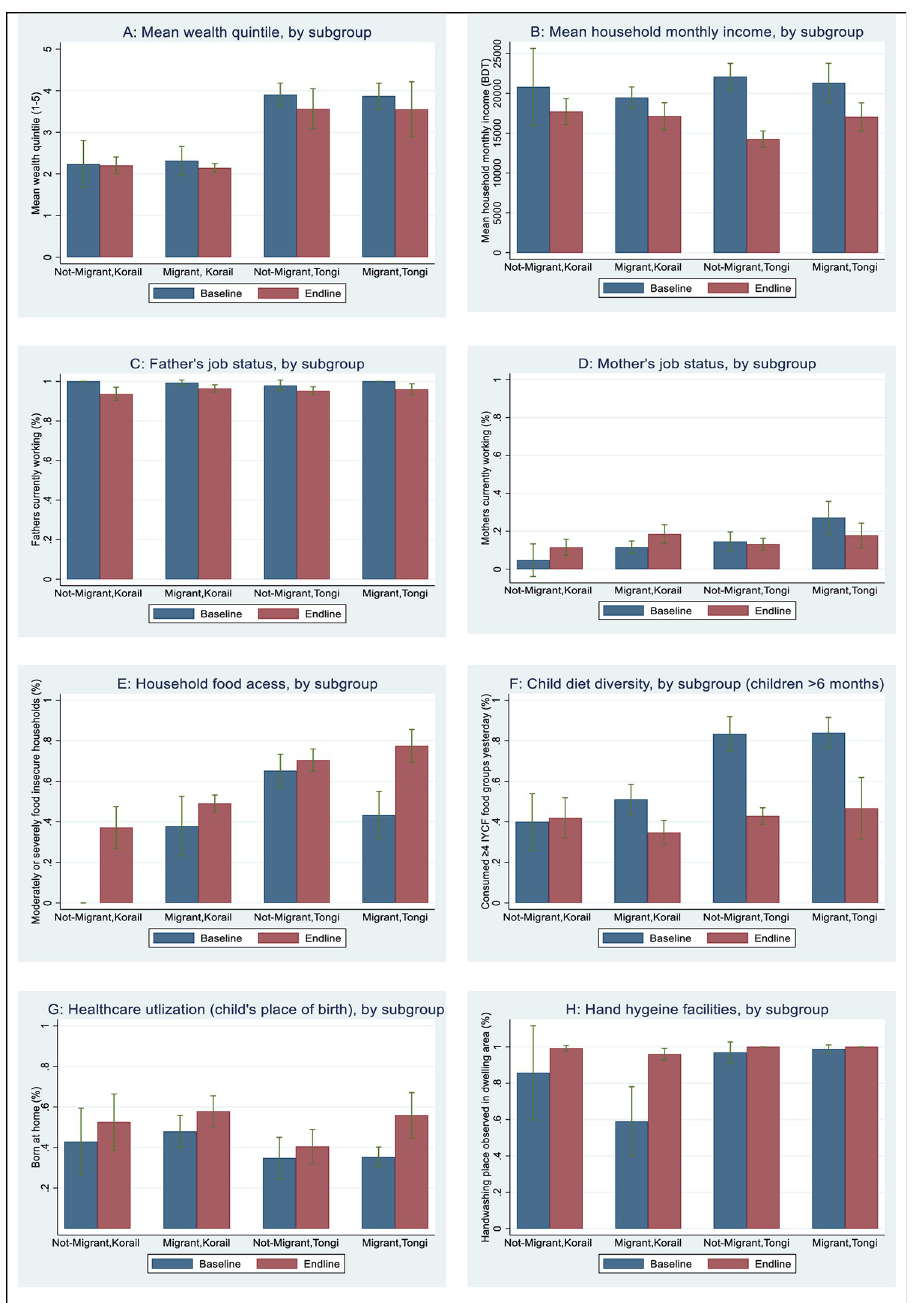
Fig 1. Estimated changes in intermediary variables between baseline and endline, by subgroup according to slum area and migration